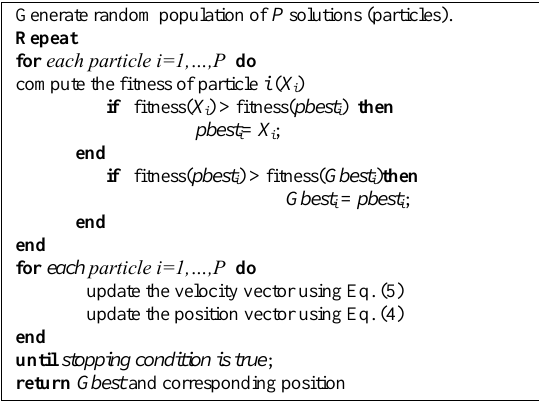
Table 1. Continuous PSO pseudocode (Elbeltagi et al. Generate random population of P solutions (particles).